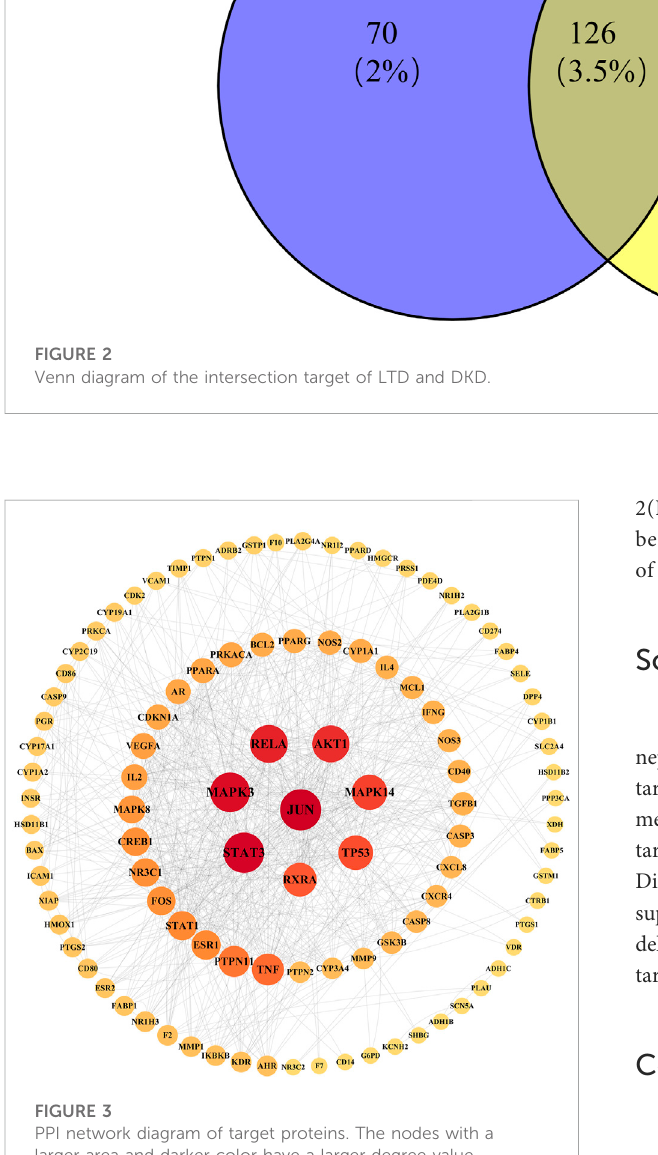
receptor coactivator 2(NCOA2), progesterone receptor (PGR), DNA topoisomerase II alpha (TOP2A), and potassium voltage-gated channel subfamily H member